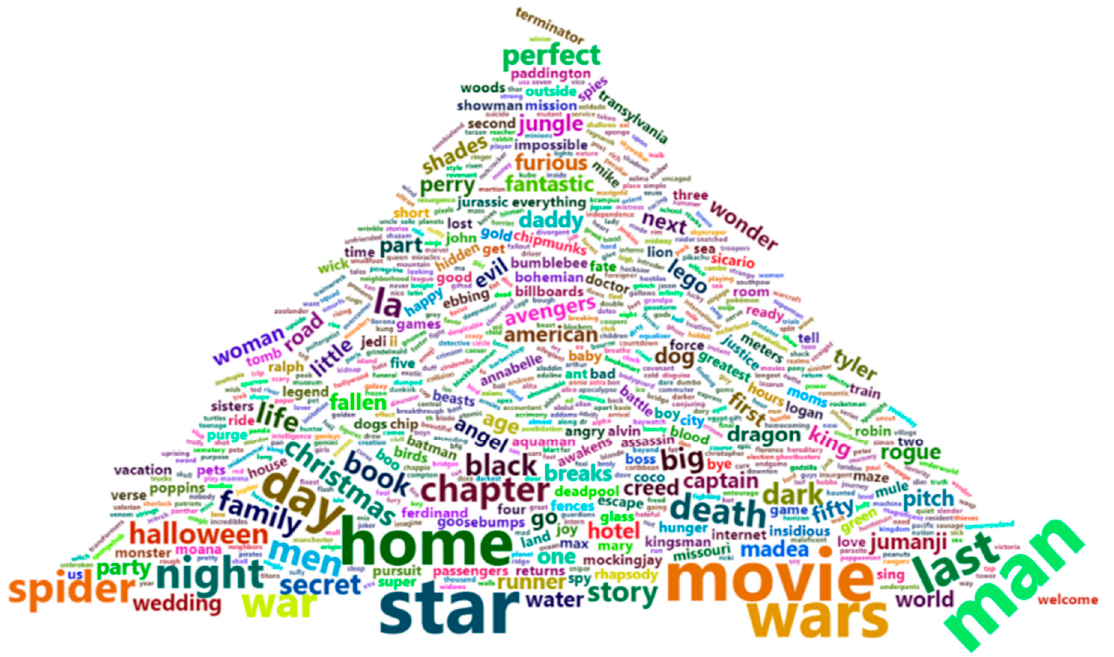
Figure 6. Word cloud of movie title keywords in